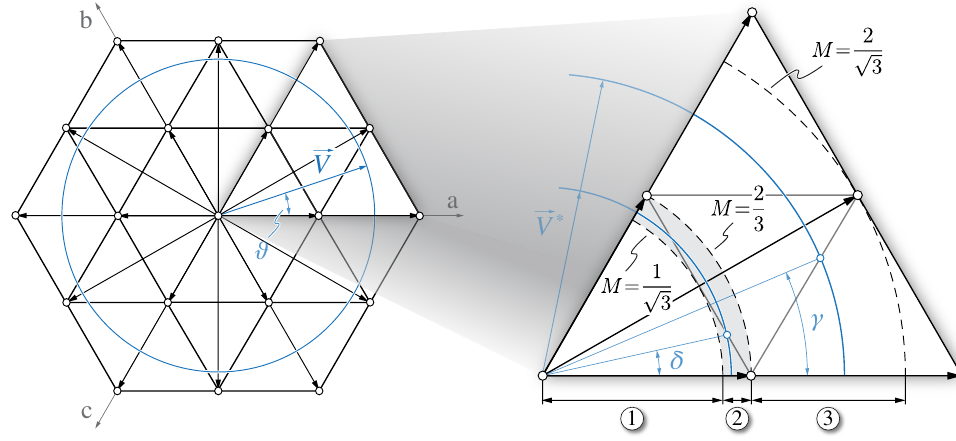
Figure A2. Overview of the modulation index regions 1 , 2 and 3 on the space vector diagram, focusing on 0 ≤ ϑ ≤ π / 3 . The transition region 2 is highlighted in grey and the most significant angle definitions for the analytical calculations are indicated (i.e., ϑ , δ , γ